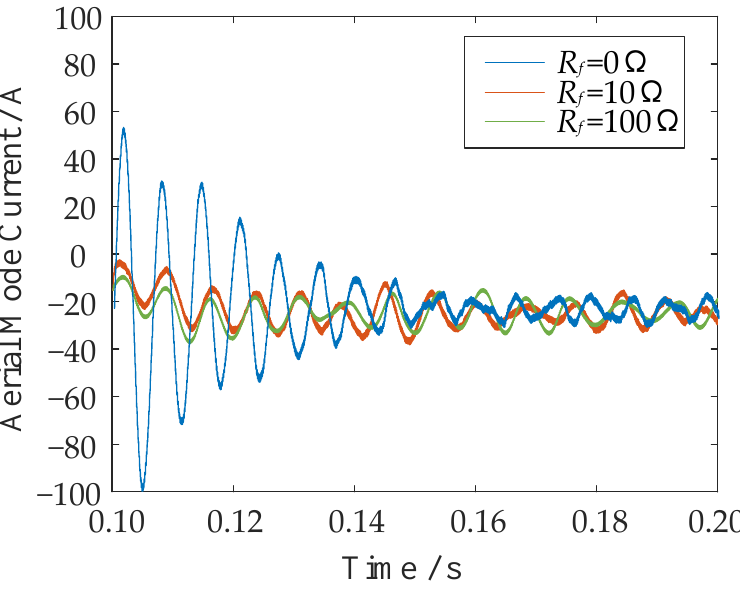
Figure 8. Aerial mode current with fault resistance.